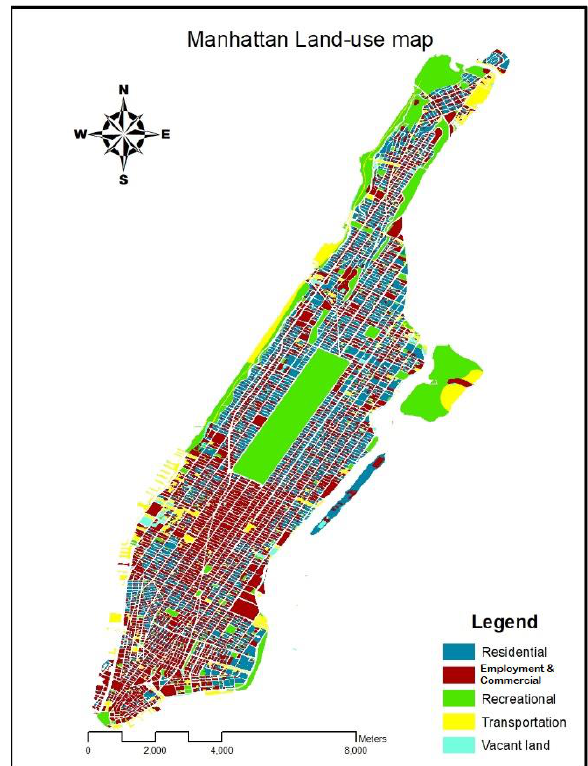
Figure 3. Manhattan Land-use